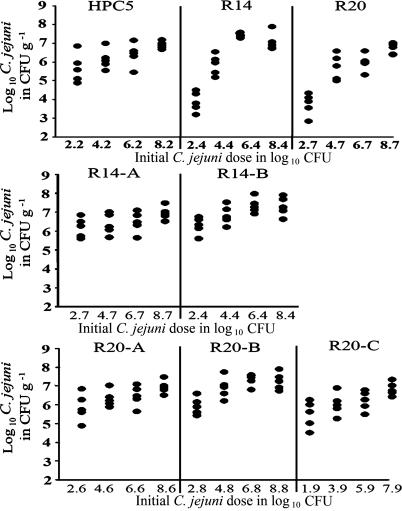
Colonisation of Broiler Chickens by Variant C. jejuni
Dose response of chickens to colonisation by C. jejuni HPC5 and its daughter strains. Each data point represents the mean cecal colonisation value (log10 CFU g−1 of cecal contents) of three determinations from a single broiler chicken 48 h after administration of the campylobacters. The doses given to each bird are indicated along the x-axis, with five birds used per group.